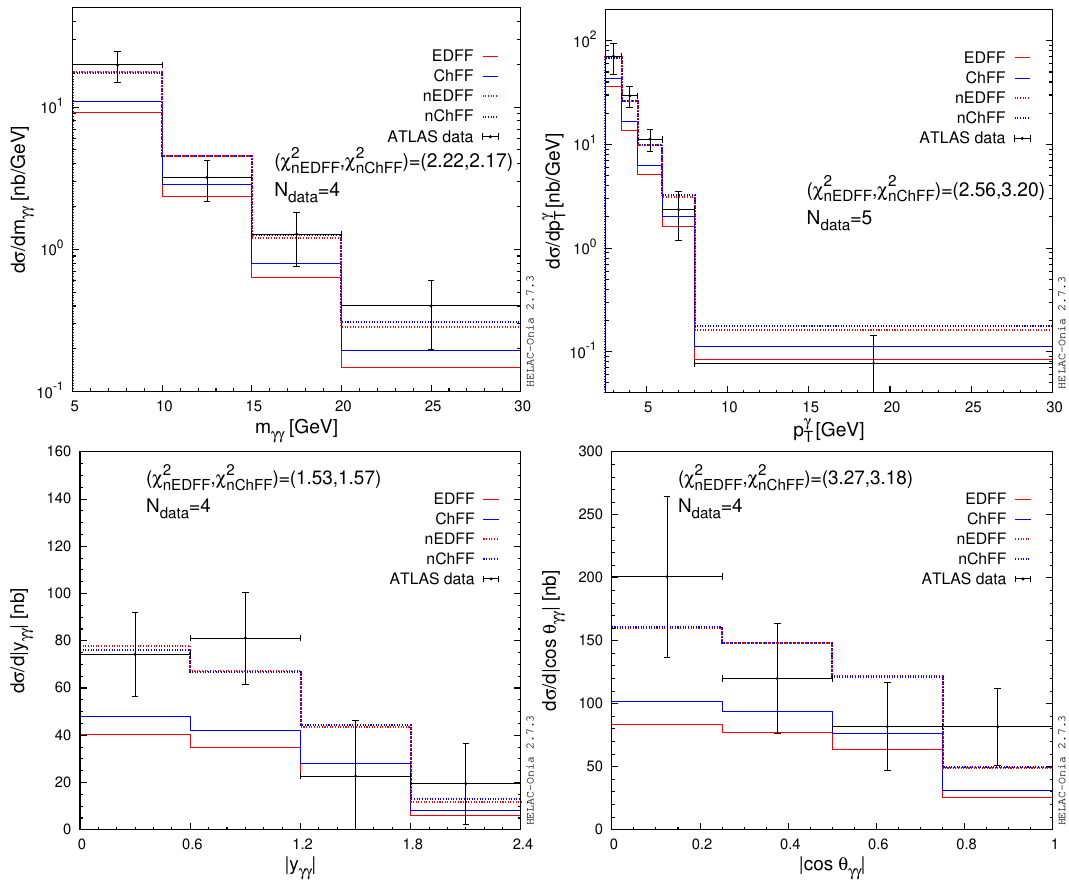
Figure 11 . Di (cid:11) erential cross sections for light-by-light scattering as a function of various diphoton variables p = 5 : 02 TeV (black data points) [15] compared to our theoretical predic- s measured in Pb-Pb UPCs at NN tions (red and blue solid-line histograms for EDFF and ChFF, respectively). The dotted histograms (labeled as normalized EDFF and ChFF, nEDFF and nChFF, respectively) are the same predictions rescaled to match the experimental value of the fiducial cross